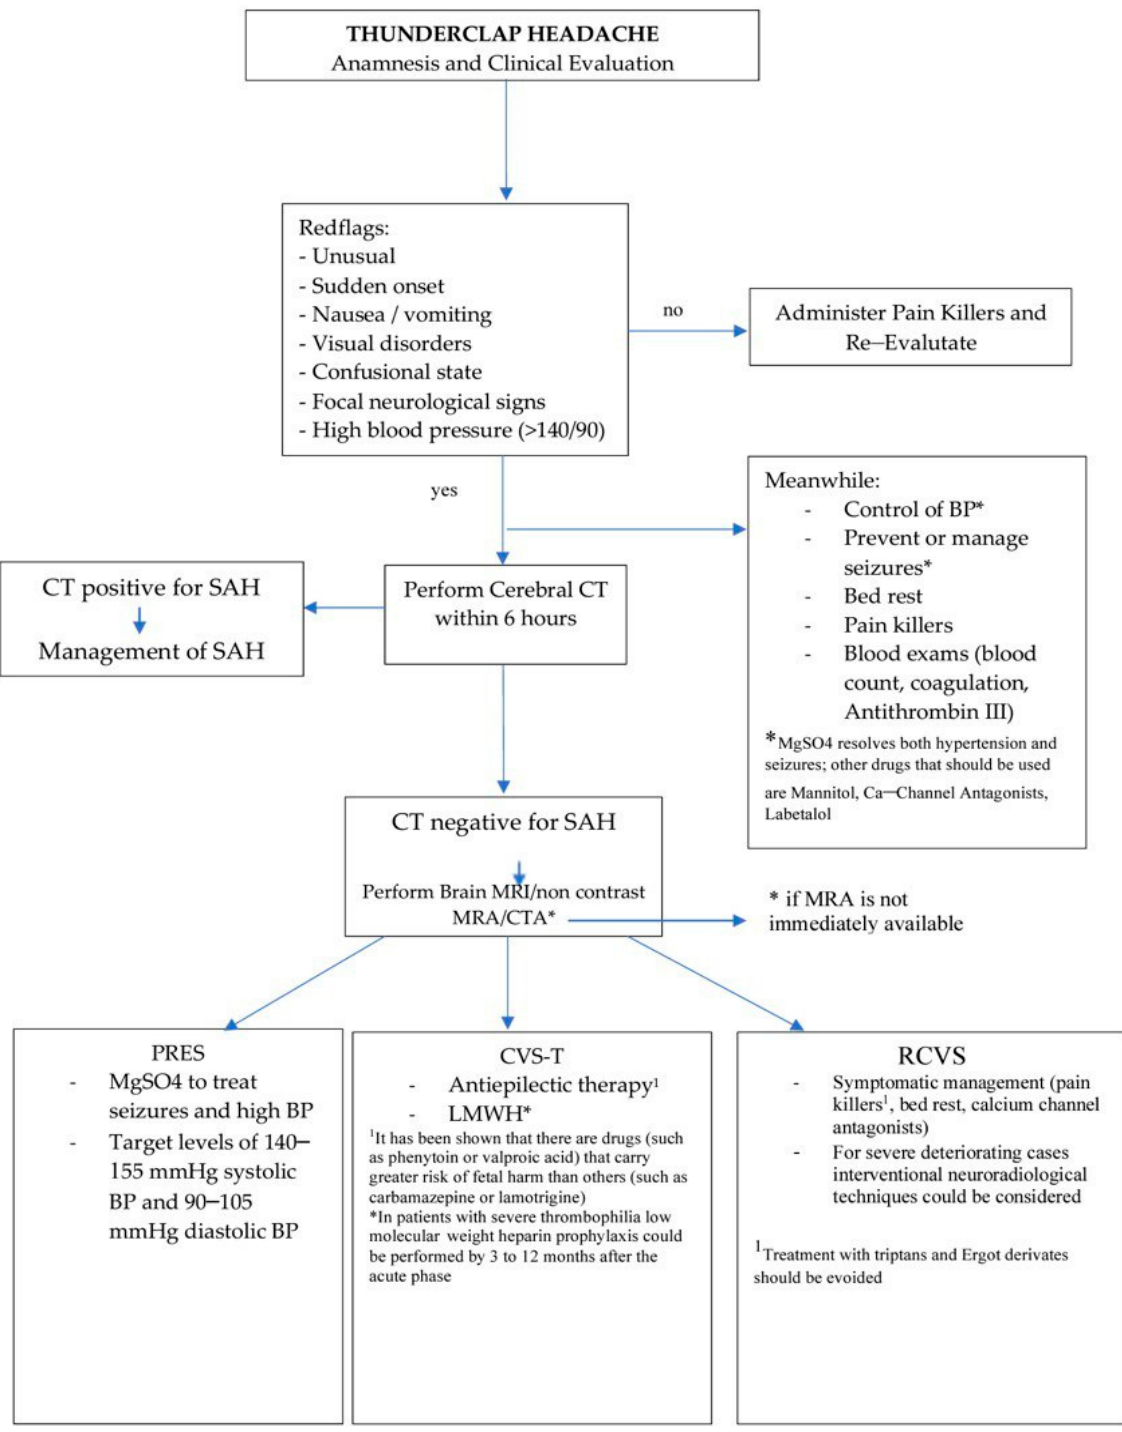
Figure 1. Algorithm for managing thunderclap headache in a clinical se tt ing.